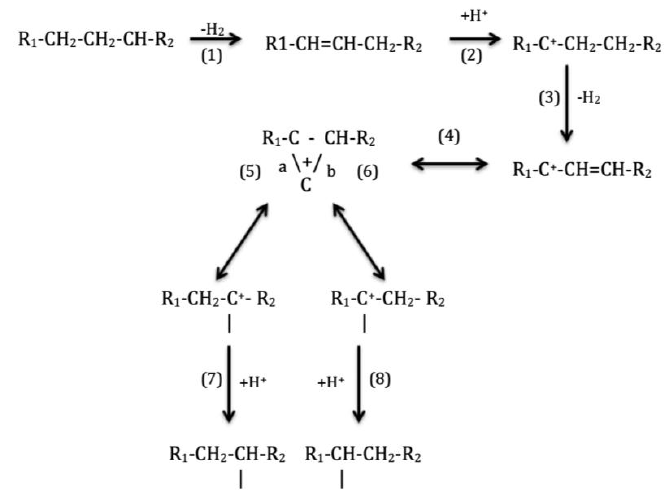
Figure 3. Reaction network for hydroisomerization of long-chain alkanes adapted from [19]. The numbers denote different reaction steps. Reproduced with permission from Zhang et al., Ind. Eng.